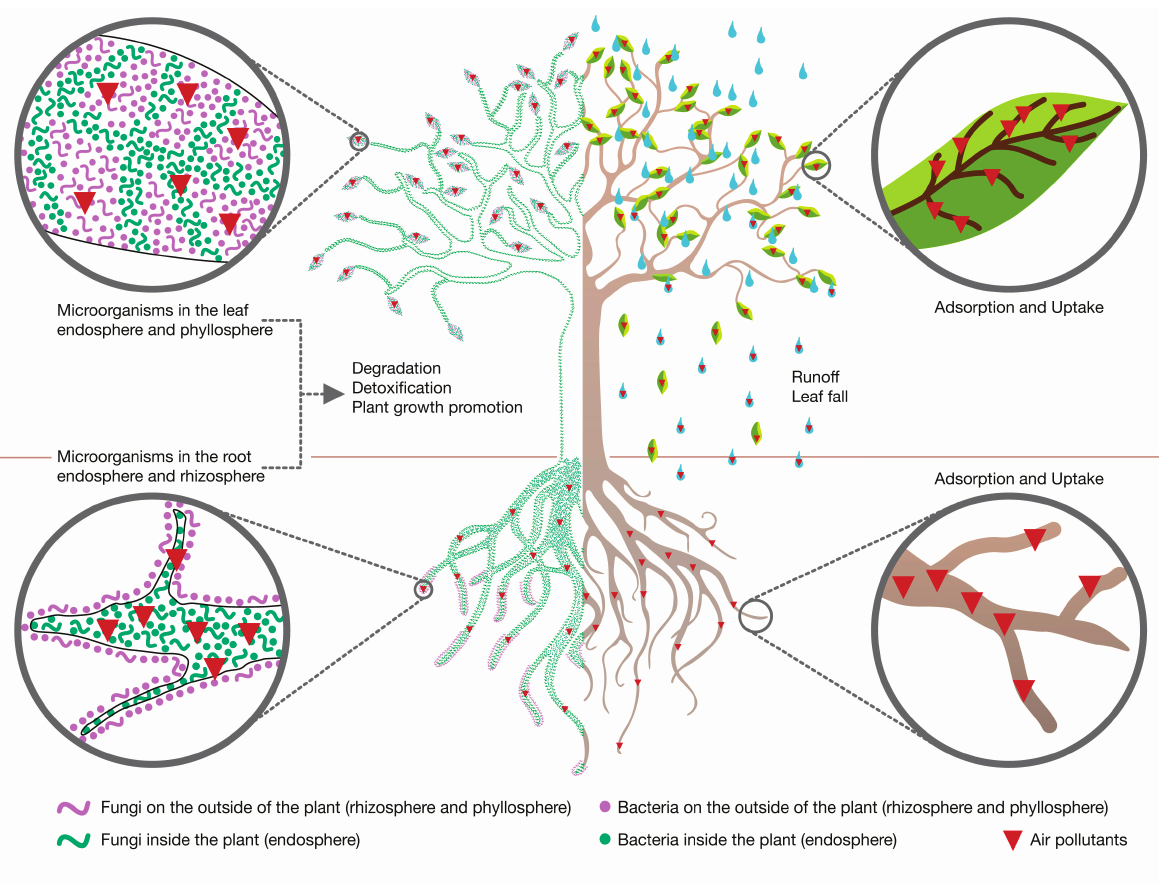
Figure 1. Schematic overview of phytoremediation of air